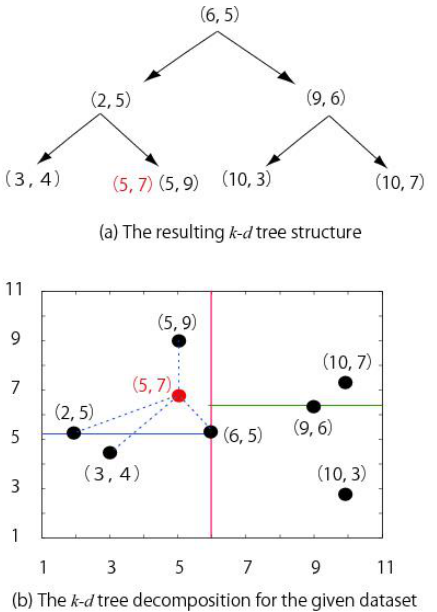
Figure 3. The k–d tree construction